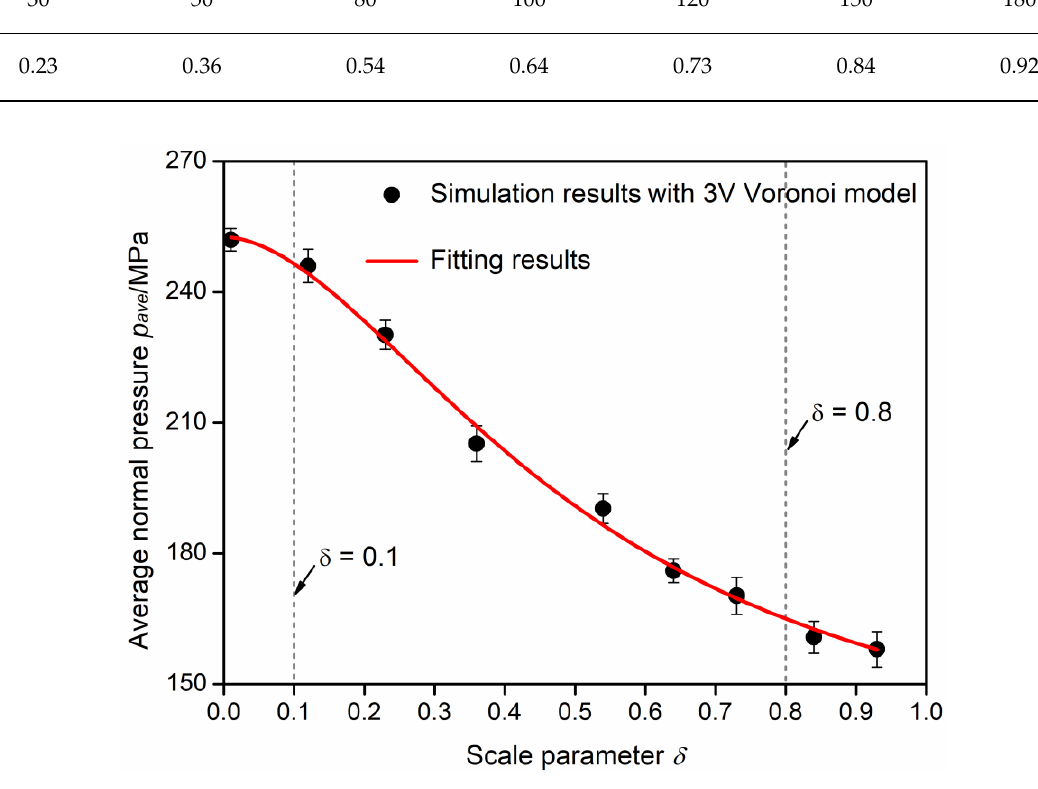
Figure 14. Changing of average normal pressure with scale